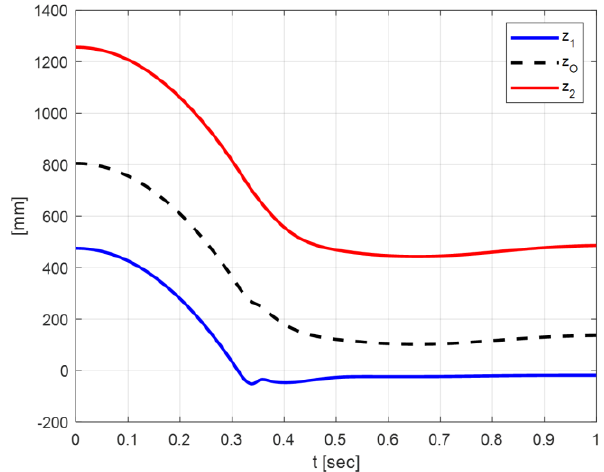
Figure 7. Time histories of vertical displacements z 1 , z 0 , and z 2 .